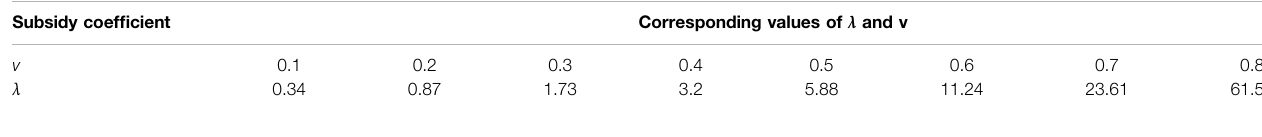
TABLE 2 | Part of the corresponding value of the subsidy coef fi cient under the two government subsidy